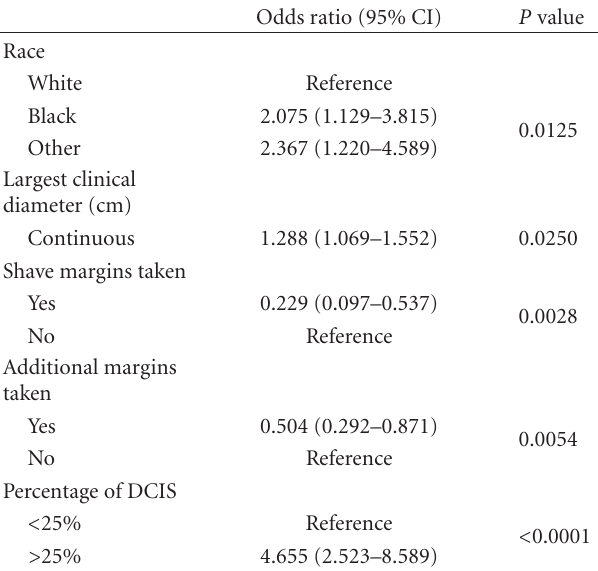
Table 3: Multivariate